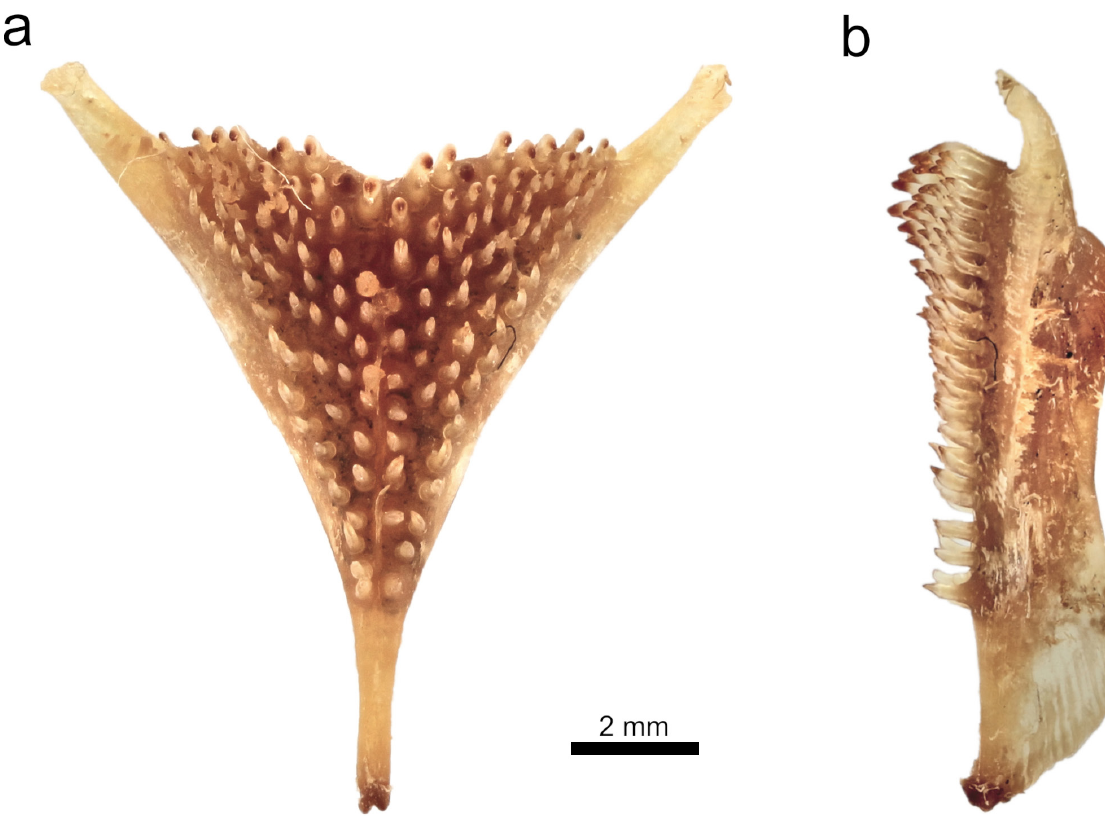
Fig. 19. Haplochromis glaucus sp. nov. (RMCA 2019.002.P.0020; 110.9 mm SL). a . Dorsal view of the lower pharyngeal jaw. b . Lateral view of the lower pharyngeal